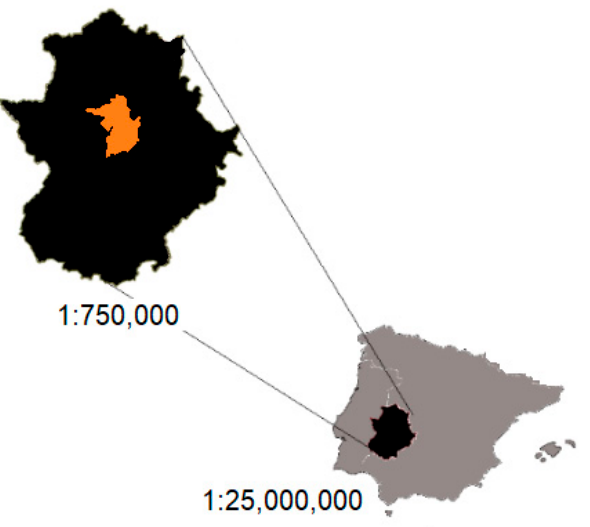
Figure 1. The geographical location of the study area in the Iberian Peninsula (orange).